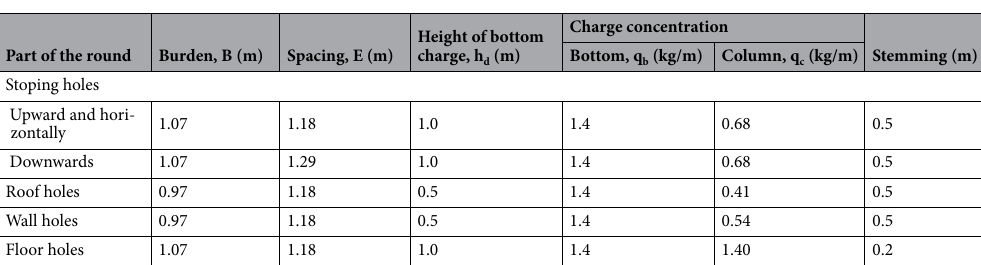
Table 4. Drilling and charging geometry for parallel